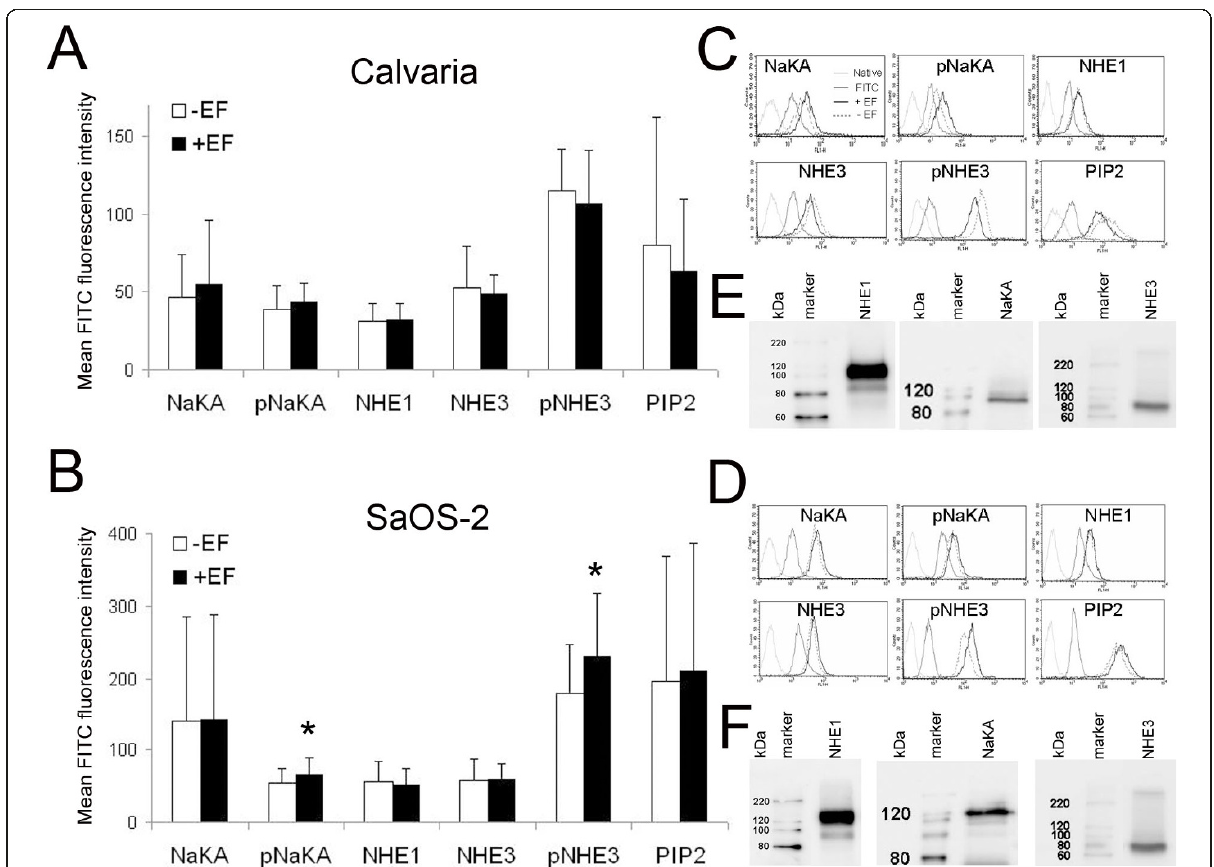
Figure 5 Changes in the protein amounts during electrotaxis. Intracellular levels of NaKA (total + phosphorylated), NHE1, NHE3 (total + phosphorylated) and PIP2 in cathodally (Calvaria) and in anodally (SaOS-2) migrating cells (A, B). Error bars represent the SEM for 11-16 separate measurements (* P = 0.01). FACS histograms that represent original measurements of NaKA (total + phosphorylated), NHE1, NHE3 (total + phosphorylated), and PIP2 from cathodally (Calvaria) and from anodally (SaOS-2) migrating cells (C, D). Images from the Western blots which show the osteoblastic isoforms of the NaKA (whole cell lysate, 110 kDa), NHE1 (whole cell lysate, 92 kDa), and NHE3 (immunprecipitate, 85 kDa) used in this study (E,